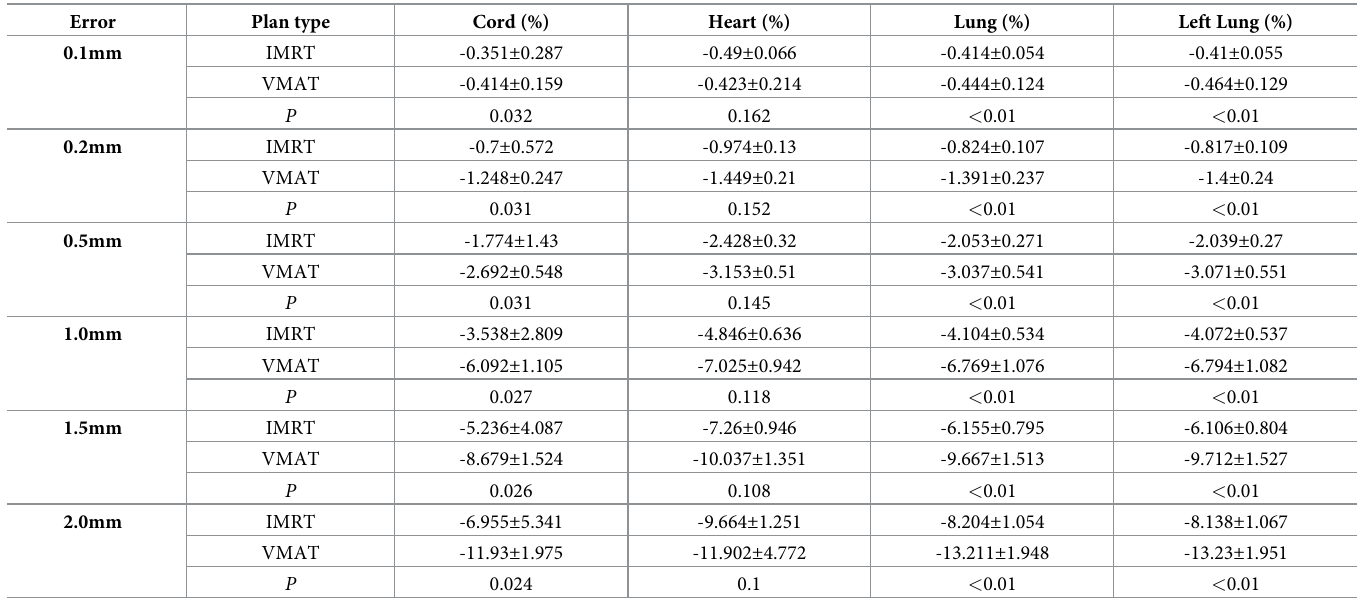
Table 3. The gEUD variation in the OAR of the IMRT and VMAT plan for closing error. Error